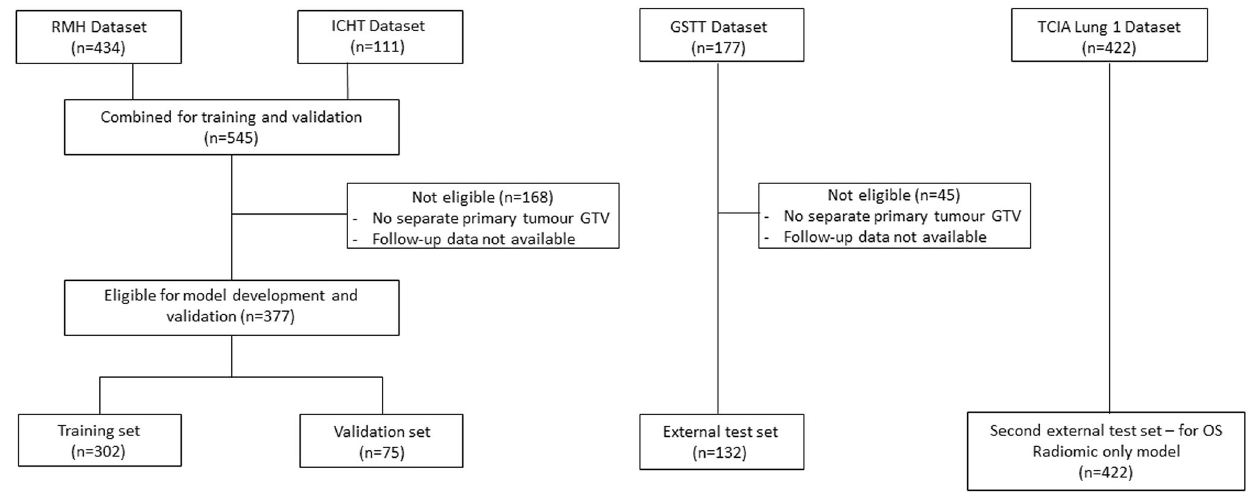
Fig. 1 Datasets used for the study. The RMH and ICHT Datasets were combined and eligible patients ( n = 377) were divided with an 80:20 ratio for training and validation. Eligible patients from the GSTT dataset ( n = 132) were used for external testing. The TCIA Lung 1 dataset ( n = 422) was used as a second external test set for the radiomic-OS model. Ineligible patients were those lacking full follow-up data or where the GTV did not encompass only the primary